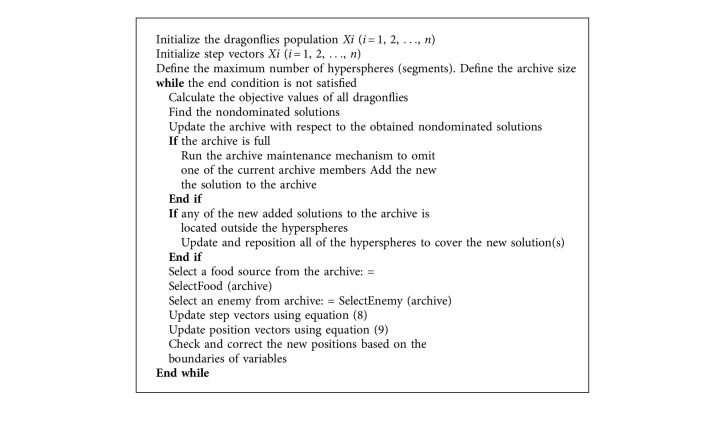
Pseudocode for MODA [9].